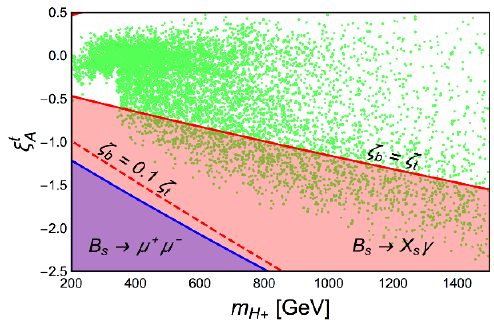
and its coupling to the top H +